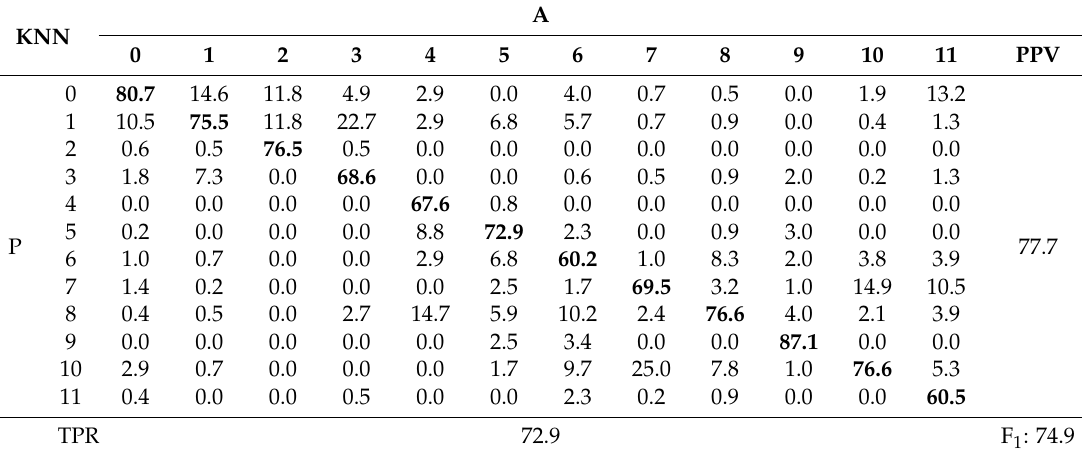
Table 6. The Confusion Matrix of the KNN Classifier.